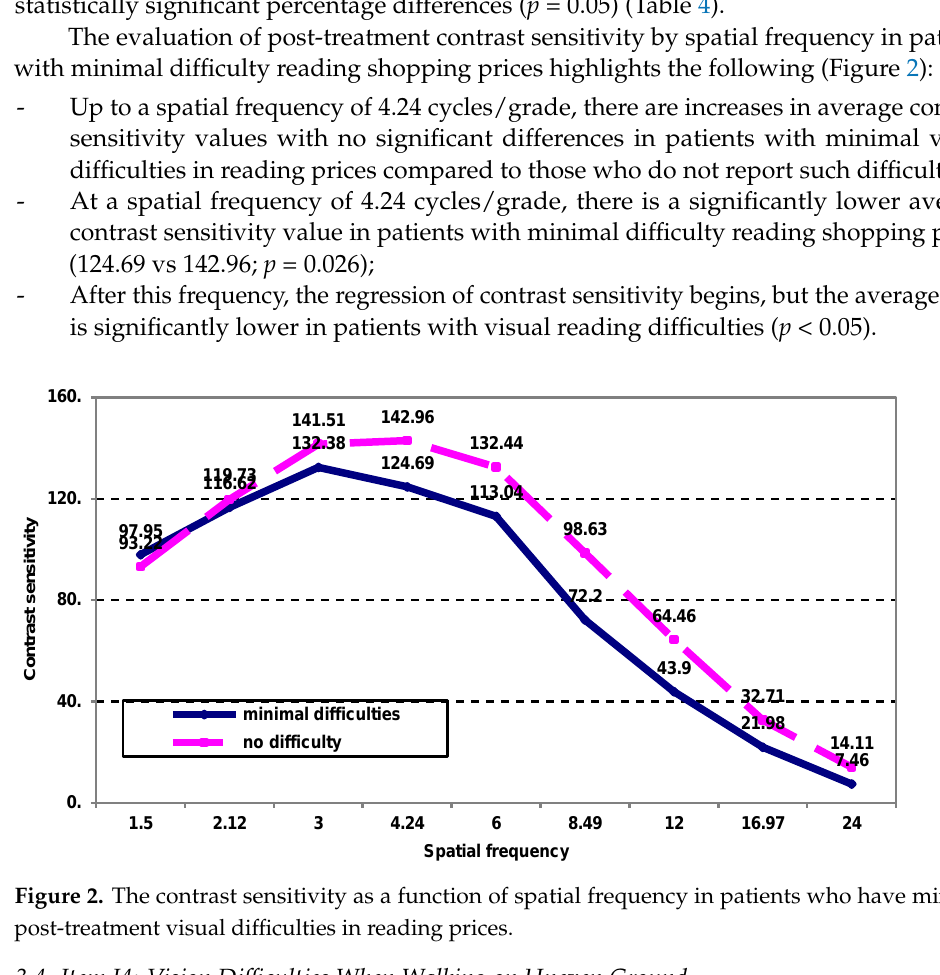
Table 5. The percentage distribution of patients with vision difficulties walking on uneven ground according to pre- and post-treatment study group characteristics .